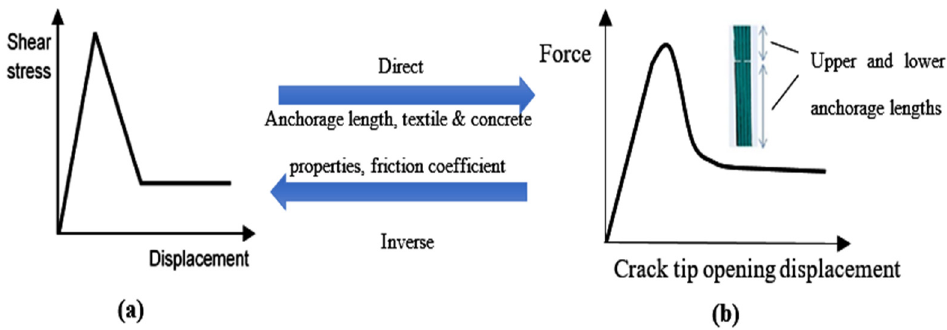
Figure 14. Inverse approach for the determination of bond-slip. ( a ) Shear stress vs. slip at interface. ( b ) Force vs. crack opening [82].